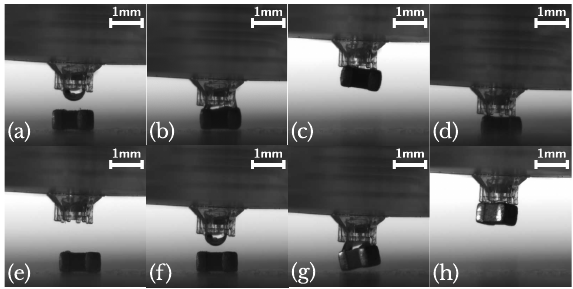
Figure 11. ( a – e )—Pick and place sequence with the gripper from Section 3. ( e – h ) correct repicking of the component [13] (see video S1 in the Supplementary